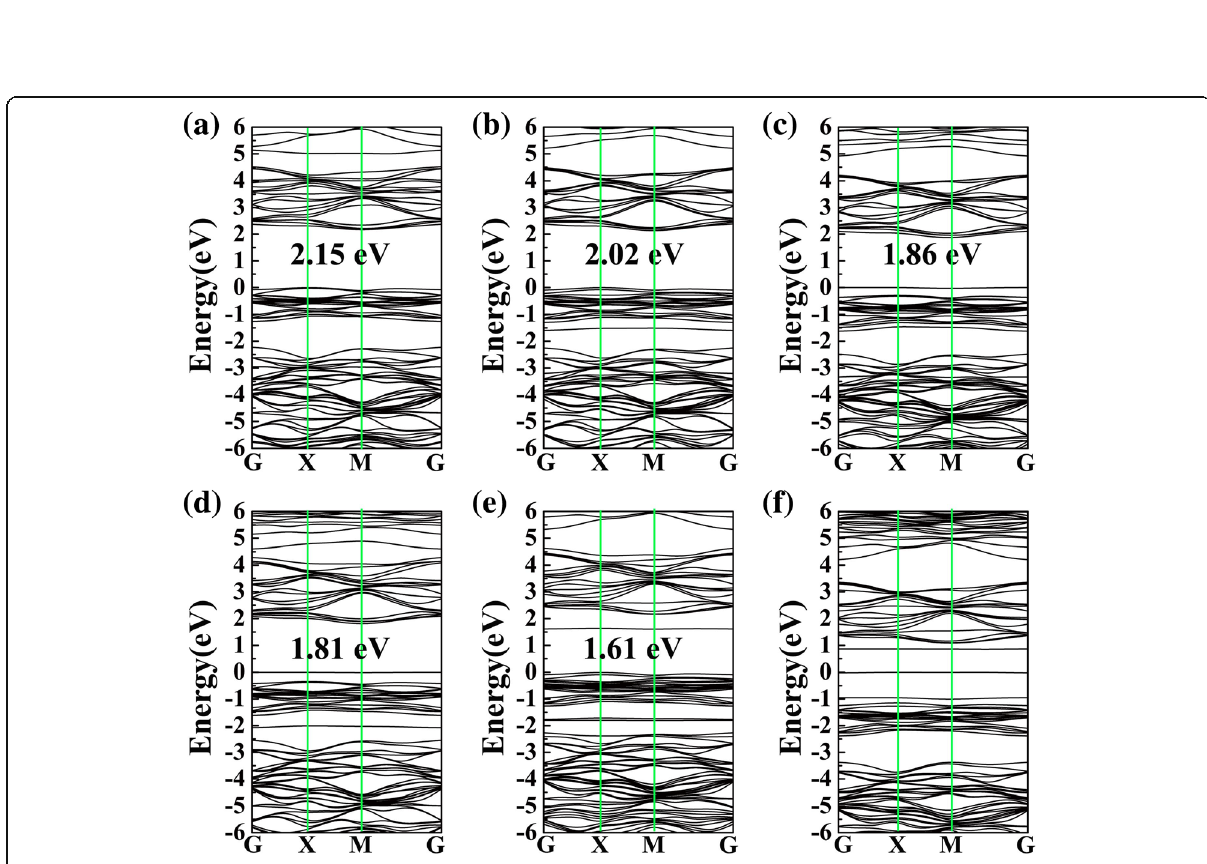
Fig. 4 Band structures of CO ( a ), H 2 O ( b ), H 2 S ( c ), NH 3 ( d ), SO 2 ( e ), and NO ( f ) on the surface of